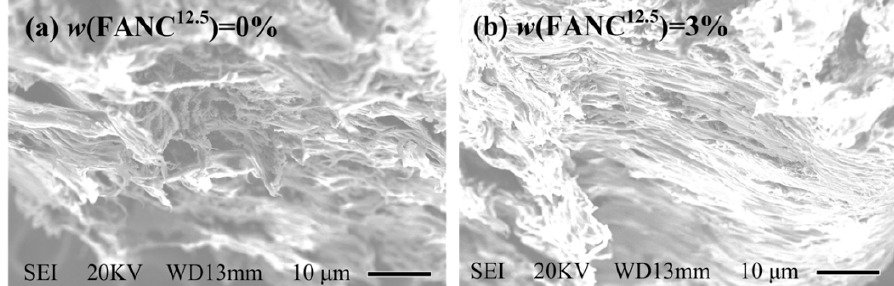
Figure 4. SEM images of the fractured surface of porous UHMWPE/FANC 12.5 specimens with the addition of NaCl particles at 60%. The magnification is 3000×. ( a ) UHMWPE with no FANC 12.5 , ( b ) UHMWPE/FANC 12.5 with the addition of FANC 12.5 at 3%.